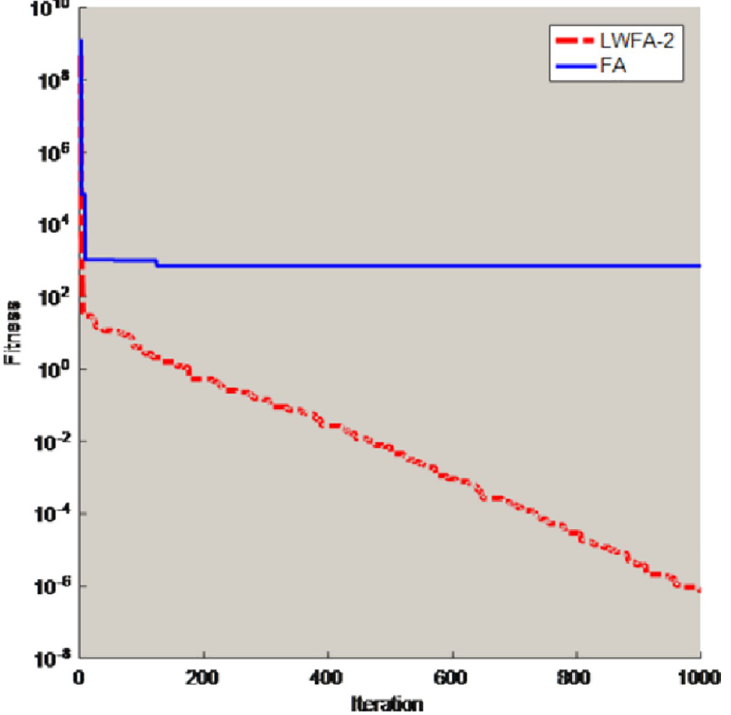
Fig 6. Convergence curves of multimodal functions f 7 .